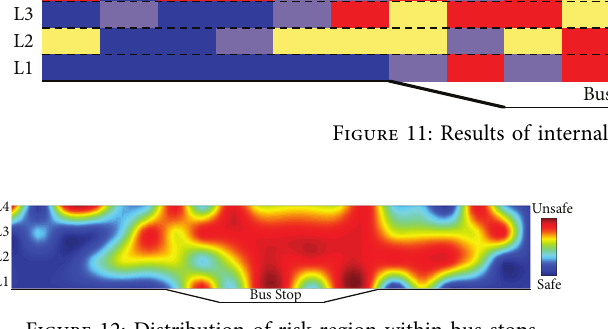
Figure 12: Distribution of risk region within bus